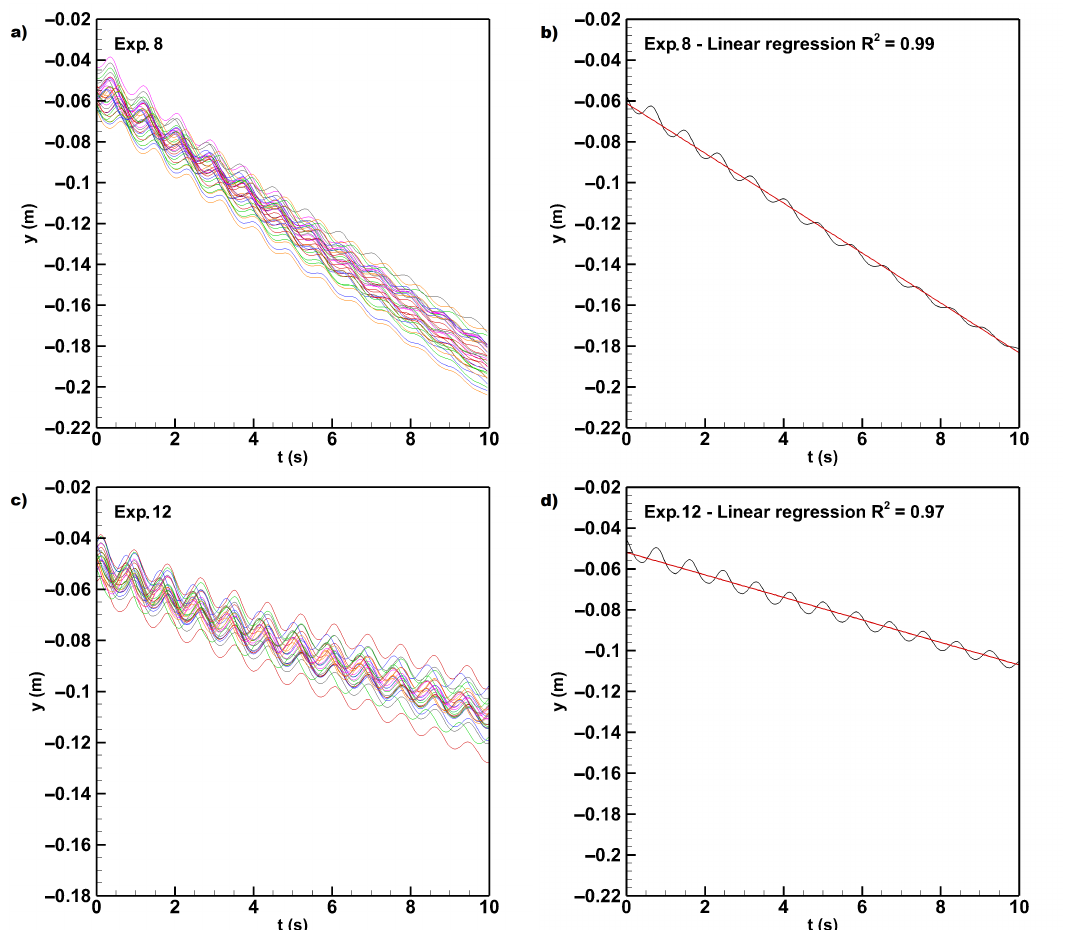
Figure 5. Time evolution of the vertical displacements for Experiments ( a ) 8 and ( c ) 12. In Panels ( b ) and ( d ) are shown the linear regressions of a single track, respectively for Experiments 8 and